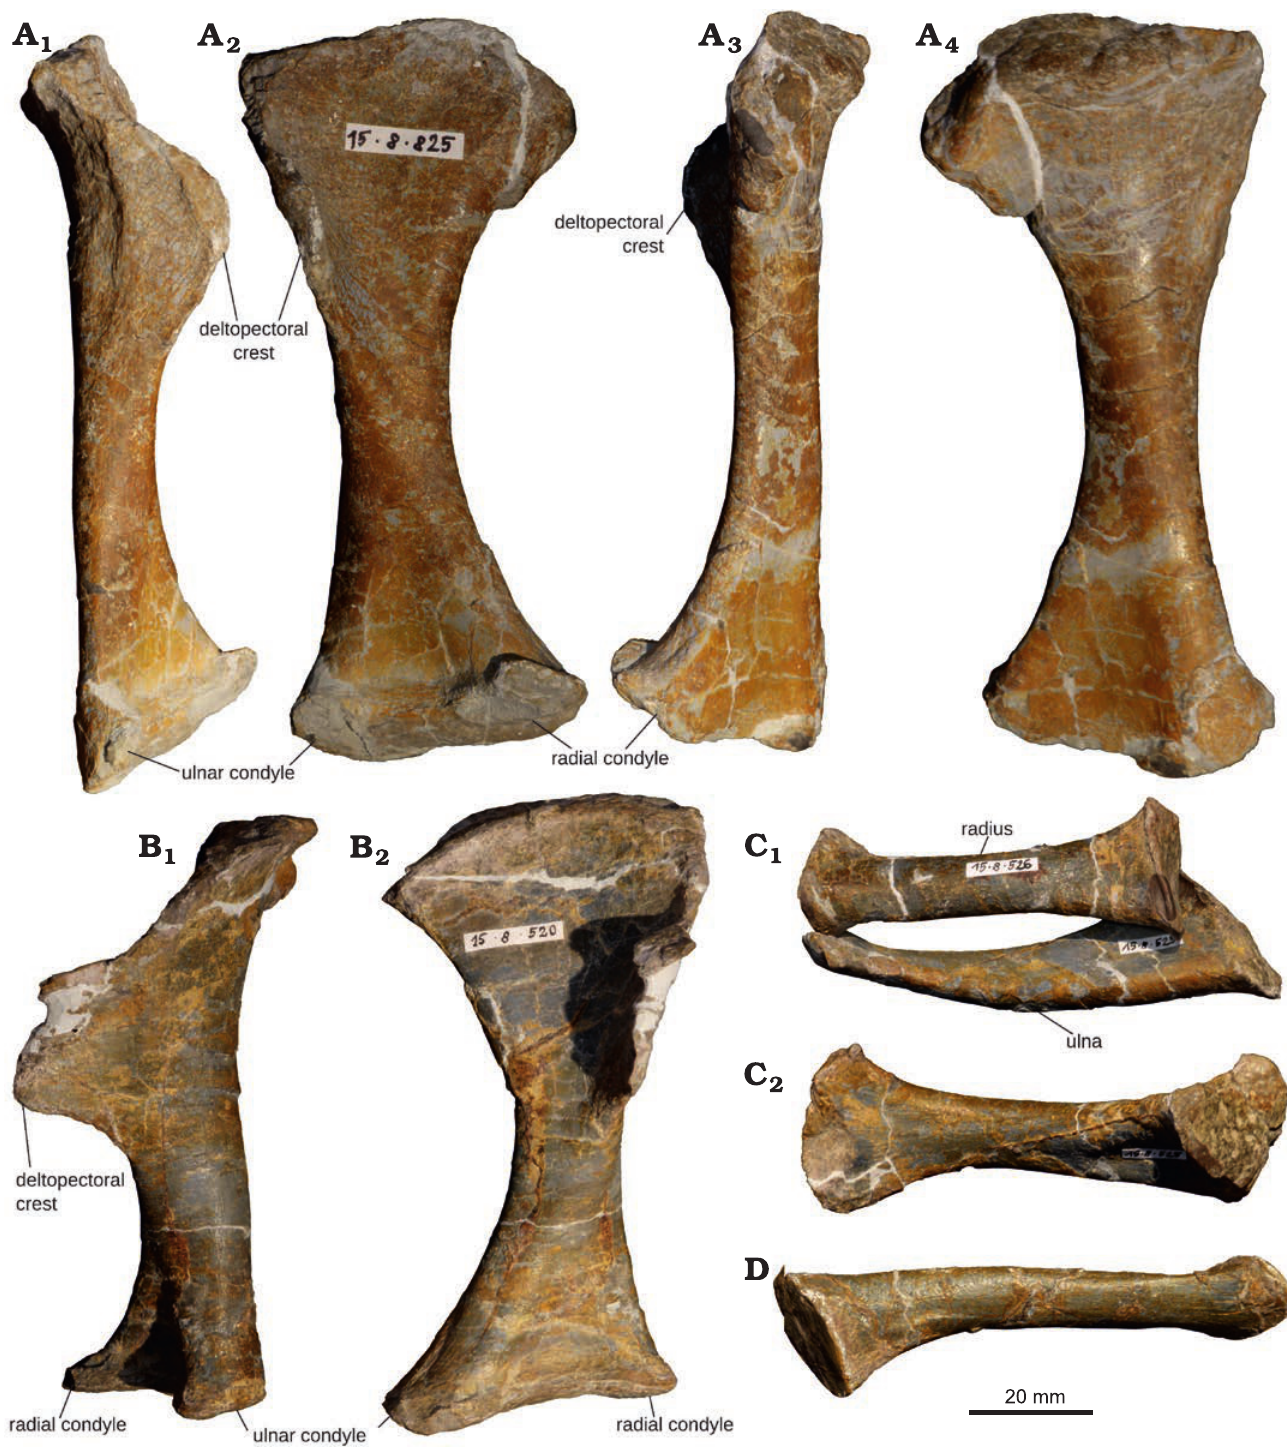
Fig. 8. Humerus and antebrachium of juvenile Plateosaurus cf. trossingensis Fraas, 1913 skeleton MSF 15.8B. from the Norian of Frick, Switzerland. A . Right humerus, MSF 15.8.825, in lateral (A 1 ), anterior (A 2 ), medial (A 3 ), and posterior (A 4 ) views. B . Left humerus, MSF 15.8.520, in lateral (B 1 ) and anterior (B 2 ) views (note effects of compaction). C . Left radius, MSF 15.8.526 and ulna, MSF 15.8.525, in lateral view (C 1 ) and left ulna, in anterior view with radius not shown (C 2 ). D . Right radius, MSF 15.8.680, in lateral Manus : The manus (Fig. 9) is proportionately long, with length of the humerus. Up to six ossified carpals, including the summed length of the longest metacarpal and digit a radiale and ulnare, have been reported in Plateosaurus. (digit II, SOM: table S6) reaching approximately 80% of the However the proximal carpals are usually not preserved